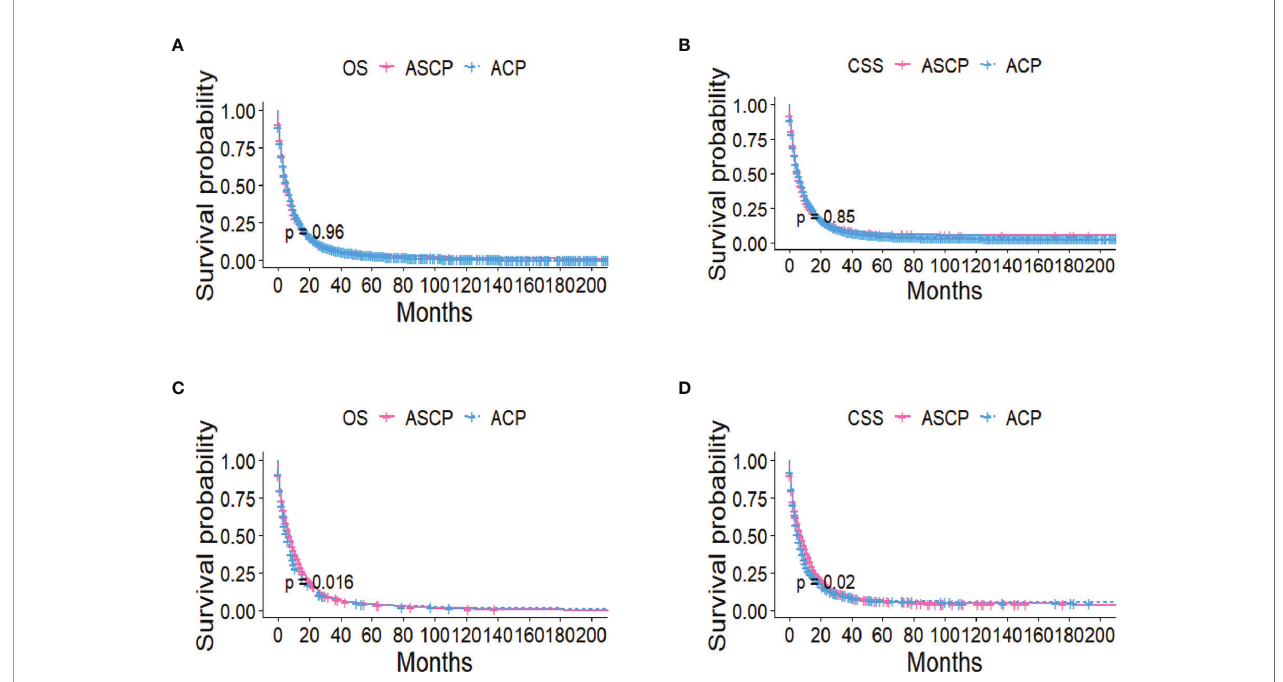
FIGURE 3 | OS and CSS of ACP and ASCP before PSM (A, B) and after PSM (C, D) (PSM, propensity score matching).